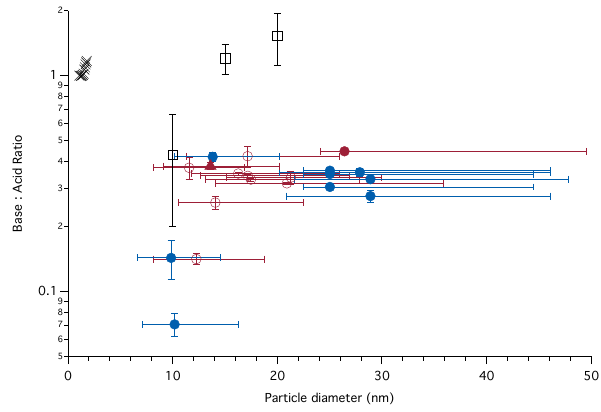
Figure 10. Base:acid TDCIMS signal ratios for DMA–H 2 SO 4 ex- periments (circles) and the H 2 SO 4 alone experiment (triangle) plot- ted against the volume median particle diameter for collected par- ticles; signal-weighted APi-TOF positive ion cluster composition (black X markers) (Bianchi et al., 2014); HTDMA-based estimates (black squares) assuming 1:1 ammonium:dimethylaminium ratio, with standard deviations ( n = 3–6) from Ahlm et al. (2016) and Kim et al. (2016). The TDCIMS base:acid ratio is the summed NH + and DMAH + ions and their clusters divided by summed sul- 4 fate peaks. Collections of less than 0.1 × 10 − 9 cm 3 of material were excluded. Only experiments for which the collected mass for the two polarities were within a factor of 2 are included in the plot, and the ratios are scaled to correct for differences in sampled mass. The filled symbols are experiments with nominally 10ppt DMA and the open symbols are with 40ppt DMA. Blue symbols indicate periods with 1%H 2 added to the TDCIMS inlet and red symbols are with- out H 2 . The vertical error bars represent the standard error of the particle ion signals, and the horizontal error bars indicate the range of particle diameters that contributed to the collected mass (min- imum 2% contribution). The TDCIMS results show consistently lower base:acid ratios than inferred by the HTDMA, but they show a similar size dependence and high variability for the smallest de- tectable